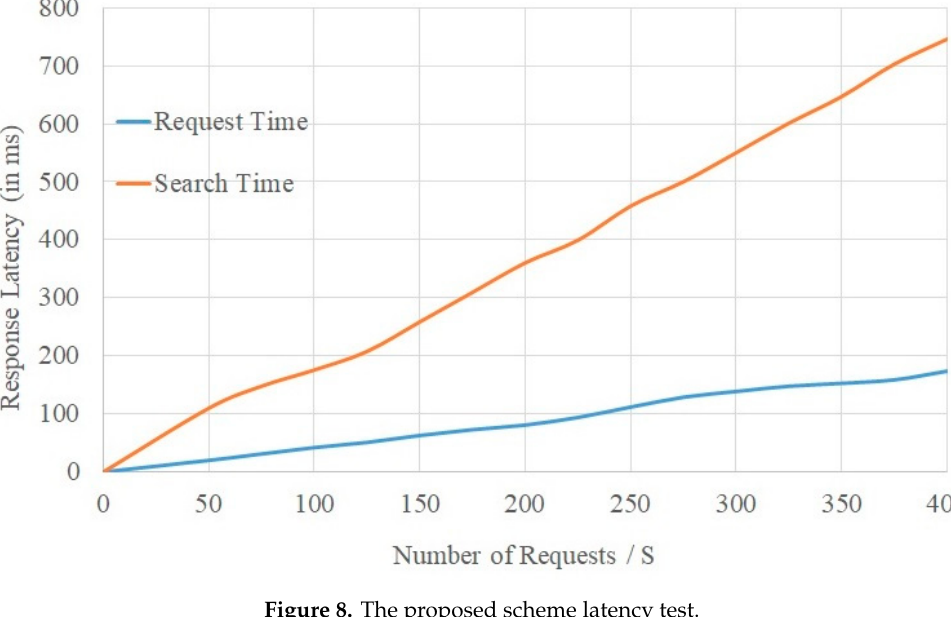
Figure 7. The generated blockchain.